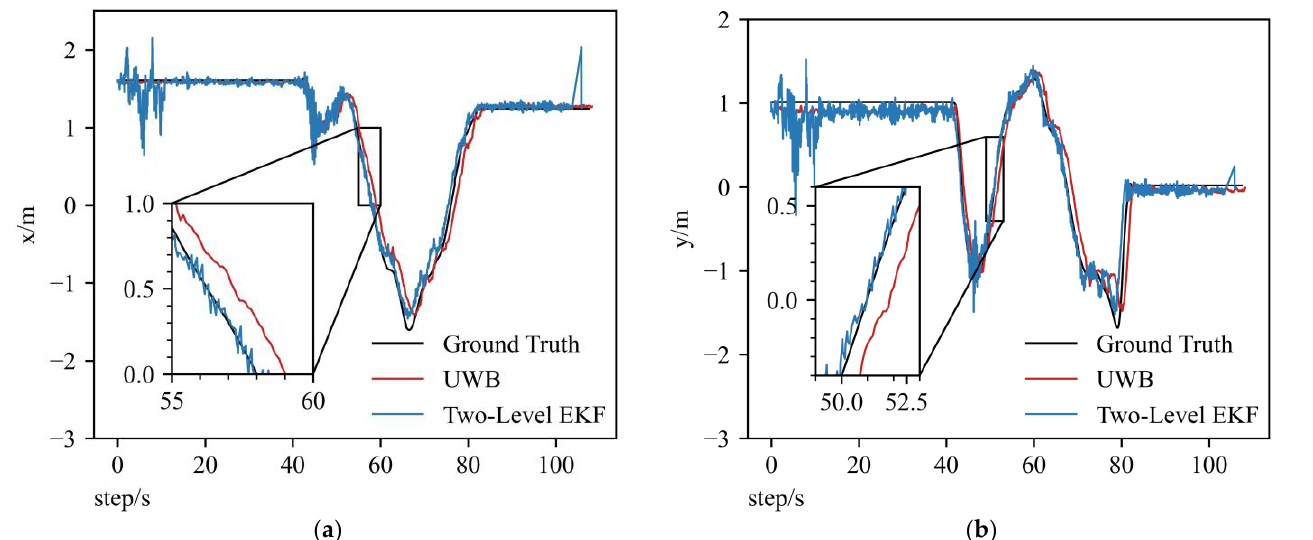
Figure 8. Partially enlarged trajectory plots of two-level error model EKF in x and y axes corresponding to ( a ) and ( b ).